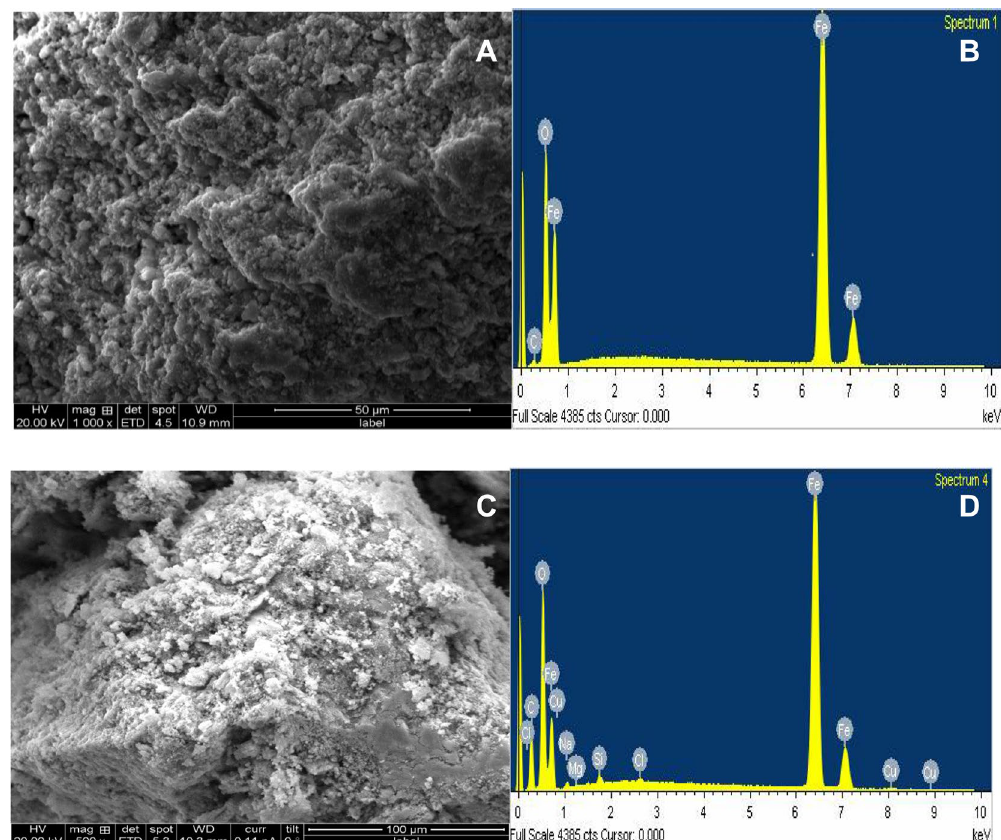
Figure 1. ( A ) SEM micrograph of nZVI before adsorption. ( B ) EDX spectrum of nZVI before adsorption. ( C ) SEM micrograph of Cu-loaded-nZVI after adsorption. ( D ) EDX of Cu-loaded-nZVI after